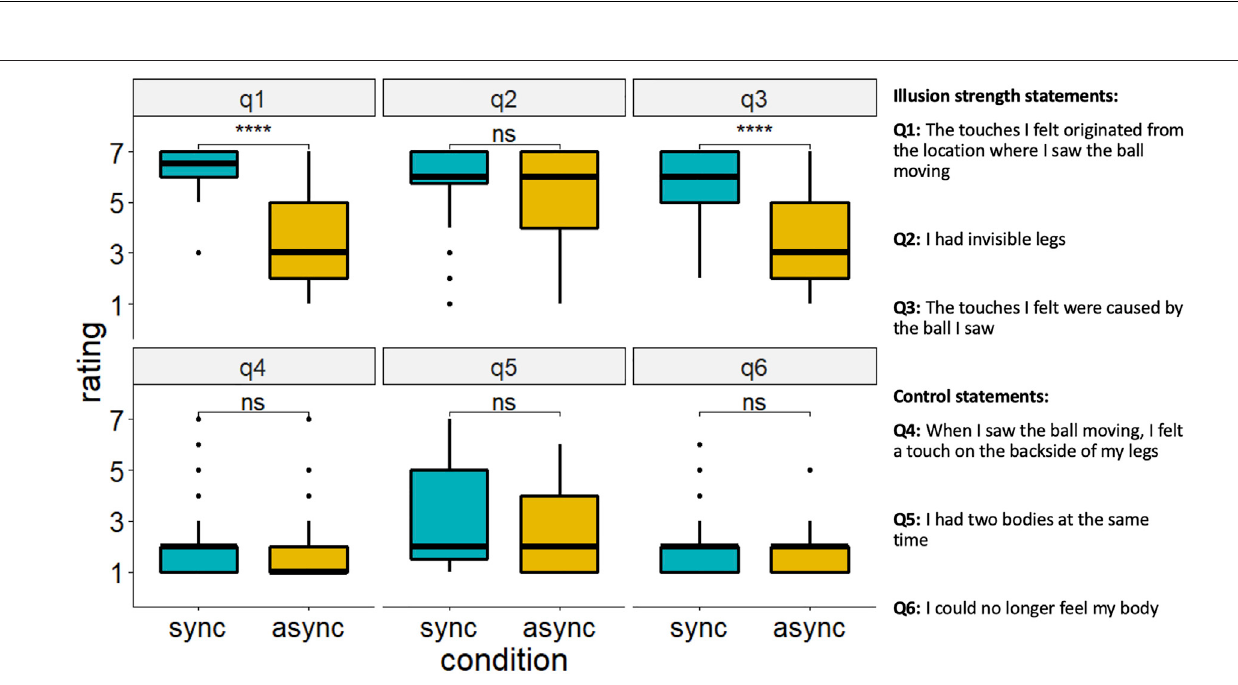
FIGURE 5 | Boxplots of the ratings for each statement in the illusion strength